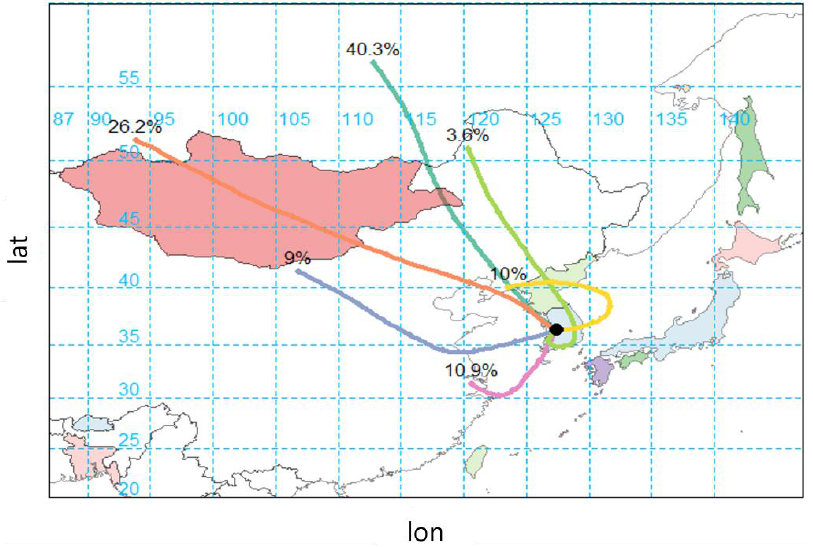
Figure 7. PM 2.5 concentration with air masses based on HYSPLIT back trajectory model .